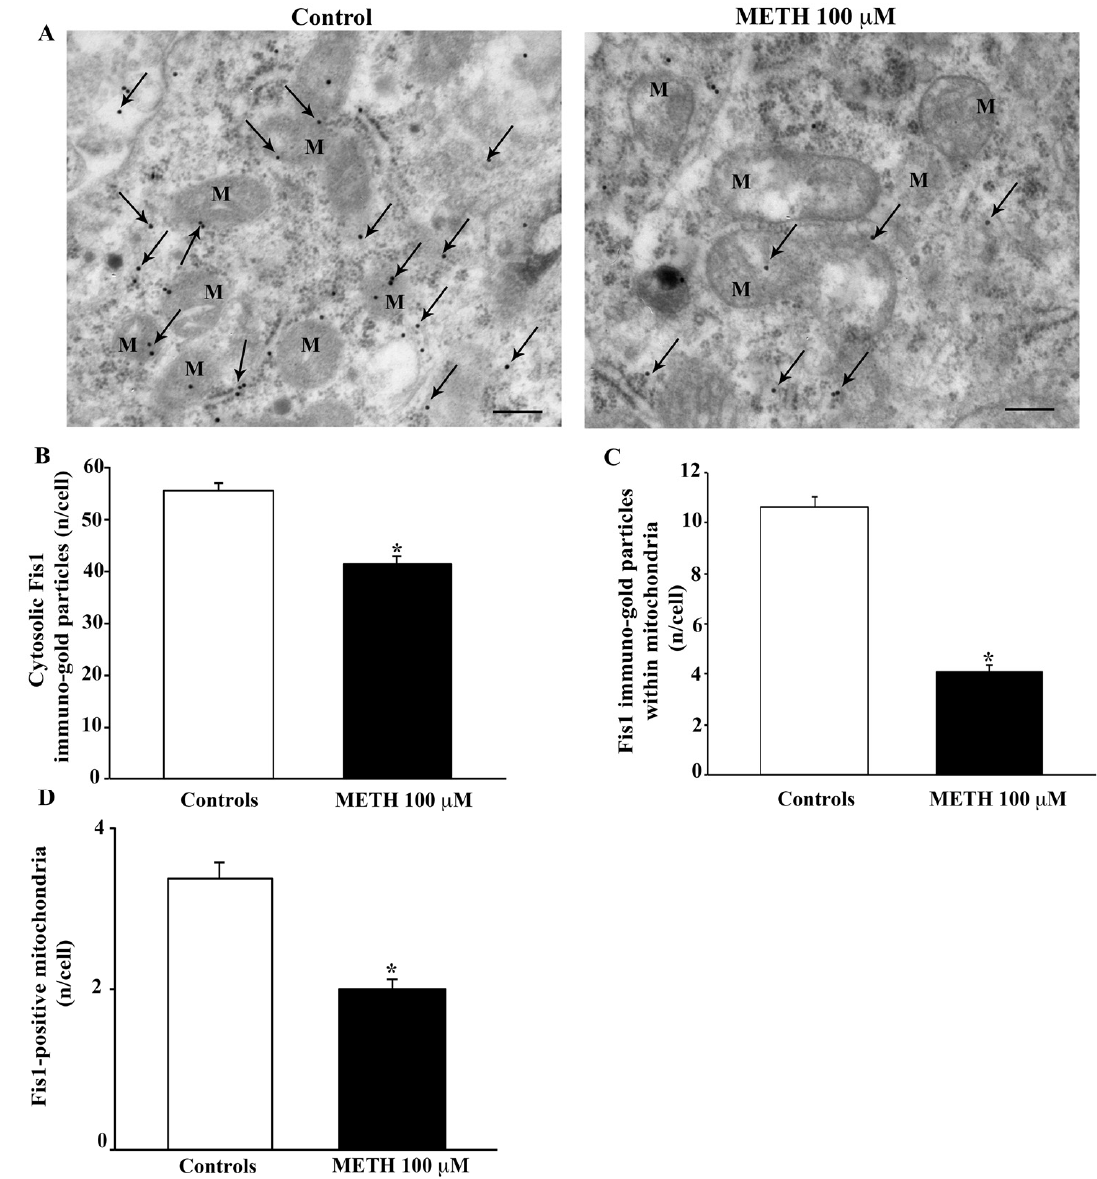
Figure 12. METH decreases the fission protein Fis1. ( A ) Representative TEM micrographs showing Fis1 particles from control and following METH 100 µ M. Arrows point to Fis1 immunogold particles within cytosol and mitochondria (M). Graph ( B ) reports the number of Fis1 immunogold particles within the cytosol. Graph ( C ) reports the number of Fis1 immunogold particles within mitochondria. Graph ( D ) indicates the number of Fis1-positive mitochondria. Values are given as the mean ± S.E.M from N = 50 cells per group. * p ≤ 0.05 compared with controls. Scale bars = 170 µ m. When immunogold detection was directed against DRP1, this protein, which is equally involved in mitochondrial fission and mitophagy, is reduced by METH as shown in the representative pictures of Figure 13A and is counted in the graphs of Figure 13B–D. The amount of such a decrease is similar within the cytosol and in situ, at mitochondrial